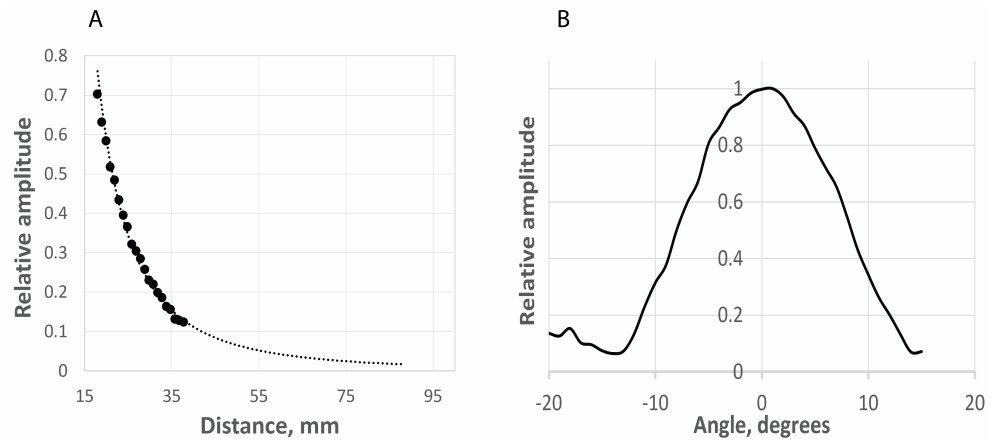
Figure 6. CMUT sensor characterization. ( A ): Attenuation, obtained with Test bench 1, see Figure 2A; ( B ): Directionality, obtained with Test bench 2, see Figure 2B.